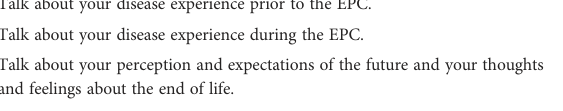
TABLE 1 Questionnaires for patients and